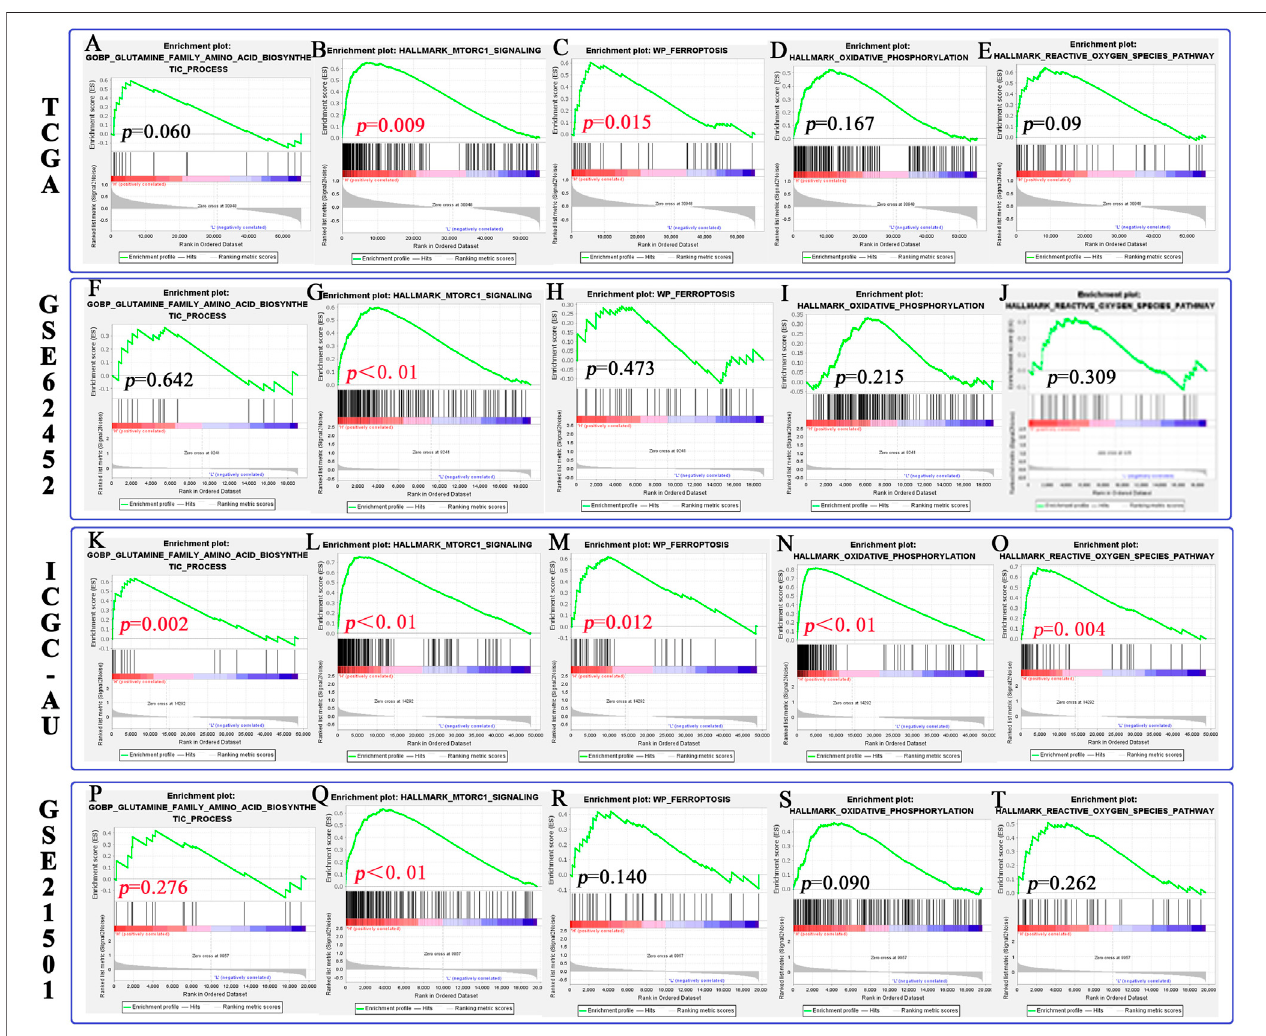
FIGURE 8 | The relationship between SLC1A5 and the mTORC1 signaling pathway, glutamine metabolism, and ferroptosis process based on GSEA. (A – E) The differences in pathway enrichment between the high- and low-SLC1A5-expression groups in the TCGA cohort. (F – J) The results of GSEA in the GSE62452 cohort. (K – O) The results of GSEA in the ICGC-AU cohort. (P – T) The results of GSEA in the GSE21501 cohort. GSEA, gene set enrichment analysis.